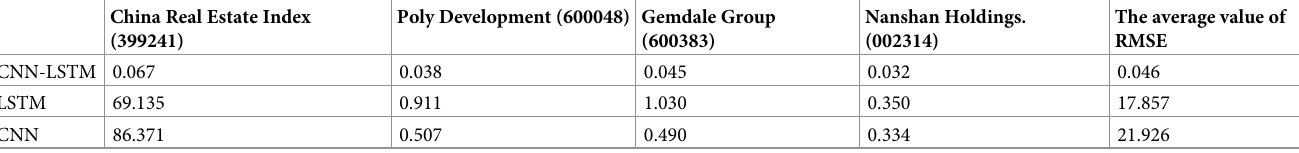
Table 2. RMSE and its average values under CNN, LSTM and CNN-LSTM